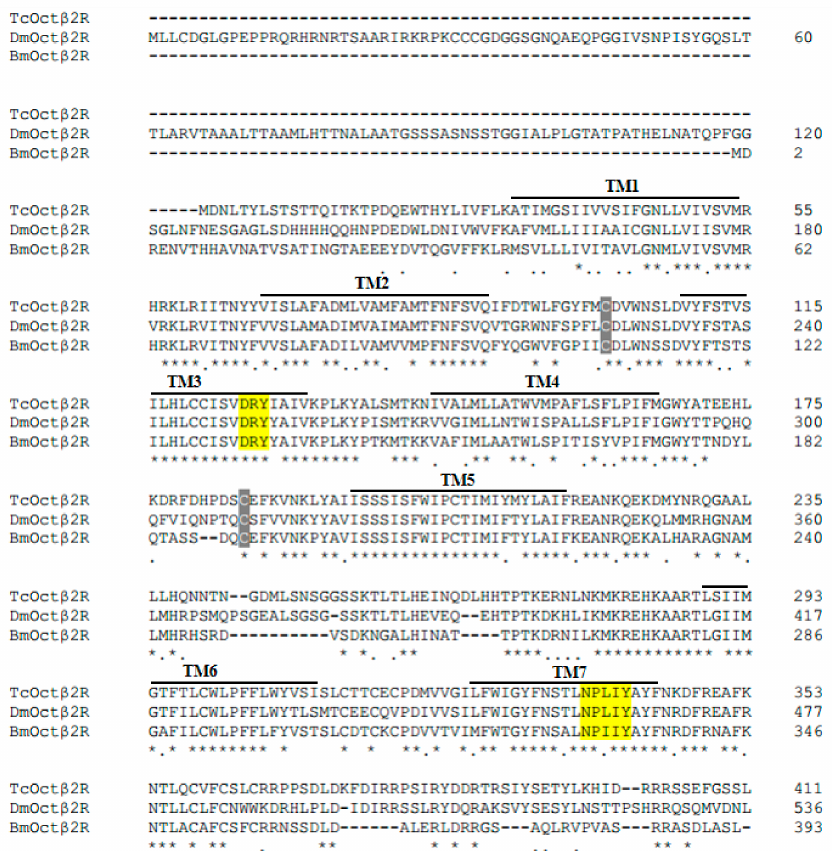
Figure 1. Multiple sequence alignment of TcOct β 2R with two β -adrenergic-like receptors from D. melanogaster (DmOct β 2R) and B. mori (BmOct β 2R). TM means transmembrane domains. The seven transmembrane domains are numbered as TM1–7. Identical amino acids are marked by asterisks, and conserved amino acids are marked by dots. The deep grey background indicates conserved cysteine residues. The yellow background indicates a conserved amino acid motif. A phylogenetic tree constructed with the insect octopamine receptors clustered into three groups, consisting of octopamine/tyramine receptors, Oct α Rs, and Oct β Rs (Figure 2). TcOct β 2R was grouped with Oct β 2Rs and showed a close relationship to AmOct β 2R of Apis mellifera and NIOct β 2R of N. lugens (Figure